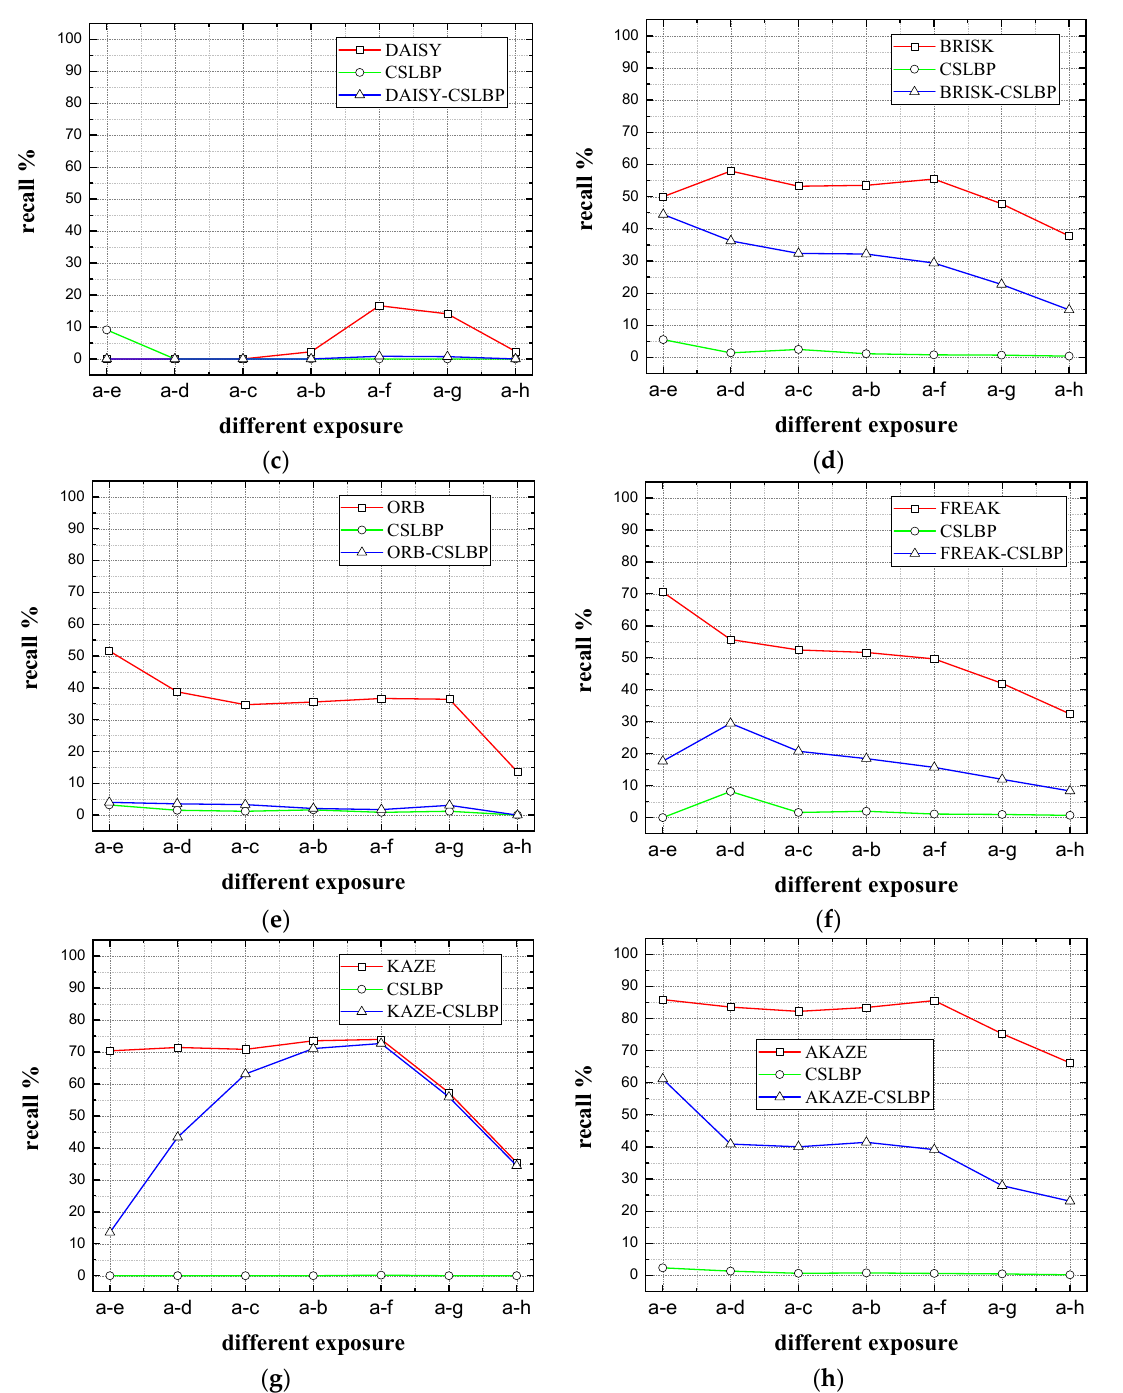
Figure 11. Matching results of the recall of Bikes sequence for the eight original, the CSLBP, and the improved descriptors. The X label represents the matched images of Bikes sequence, and the Y label denotes the recall for each descriptor. ( a ) SIFT features; ( b ) SURF features; ( c ) DAISY features; ( d ) BRISK features; ( e ) ORB features; ( f ) FREAK features; ( g ) KAZE features; ( h ) AKAZE features.